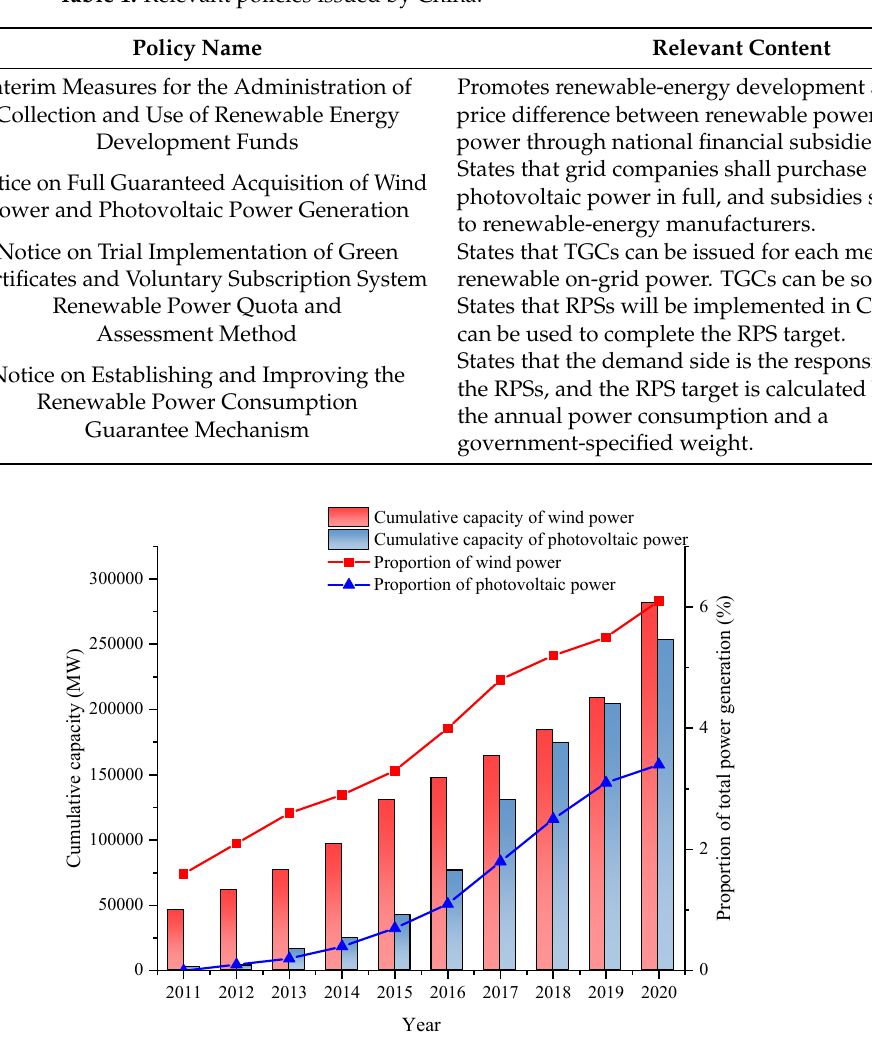
Figure 1. Trends of renewable-power development in China from 2011 to 2020. In 2017, to ensure sustainable development of renewable energy and ease fi nancial pressure, China introduced TGC issuing and a voluntary subscription policy. However, due to the lack of mandatory constraints and assessment mechanisms, the scale of TGC transactions is very limited.